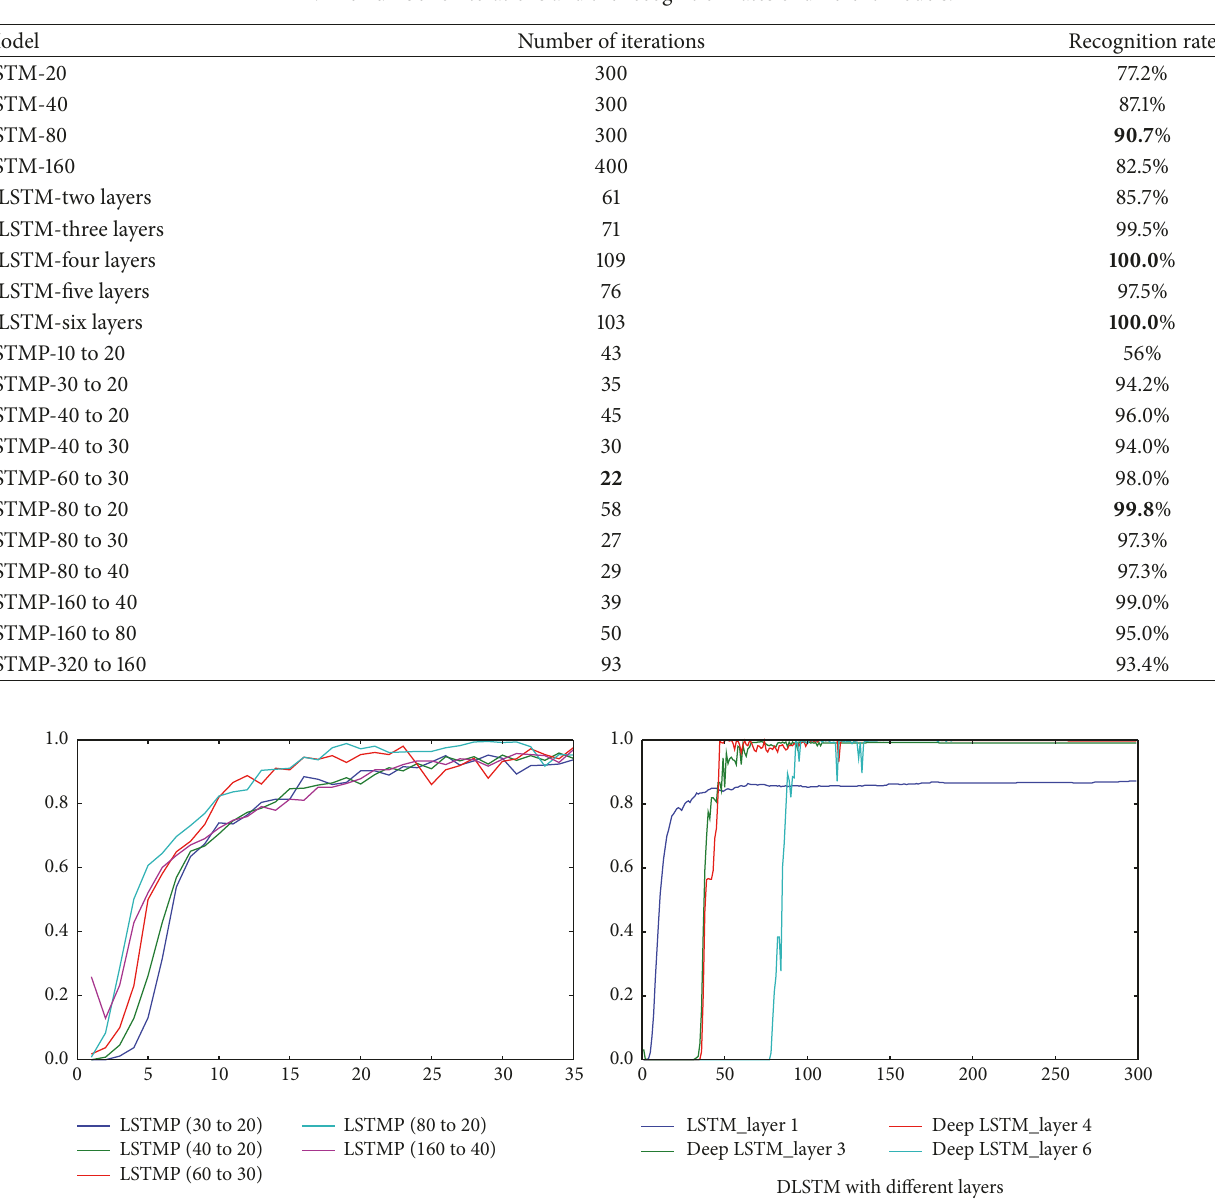
Table 1: The number of iterations and the recognition rates of different models.